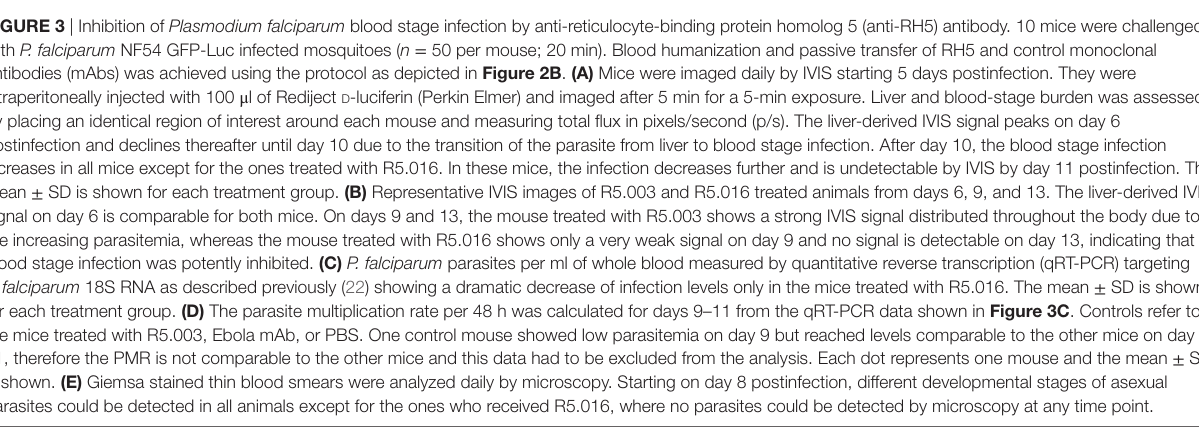
FIGURe 3 | Inhibition of Plasmodium falciparum blood stage infection by anti-reticulocyte-binding protein homolog 5 (anti-RH5) antibody. 10 mice were challenged with P. falciparum NF54 GFP-Luc infected mosquitoes ( n = 50 per mouse; 20 min). Blood humanization and passive transfer of RH5 and control monoclonal antibodies (mAbs) was achieved using the protocol as depicted in Figure 2B . (A) Mice were imaged daily by IVIS starting 5 days postinfection. They were intraperitoneally injected with 100 μ l of Rediject d -luciferin (Perkin Elmer) and imaged after 5 min for a 5-min exposure. Liver and blood-stage burden was assessed by placing an identical region of interest around each mouse and measuring total flux in pixels/second (p/s). The liver-derived IVIS signal peaks on day 6 postinfection and declines thereafter until day 10 due to the transition of the parasite from liver to blood stage infection. After day 10, the blood stage infection increases in all mice except for the ones treated with R5.016. In these mice, the infection decreases further and is undetectable by IVIS by day 11 postinfection. The